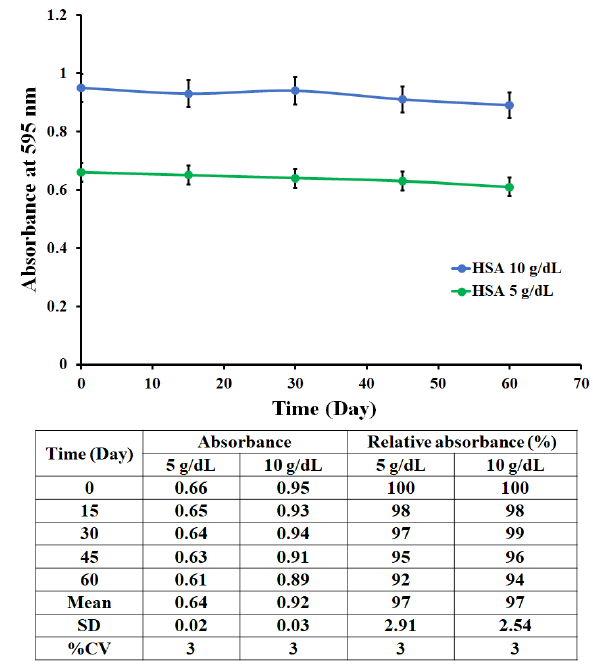
Figure 11. Storage stability test.